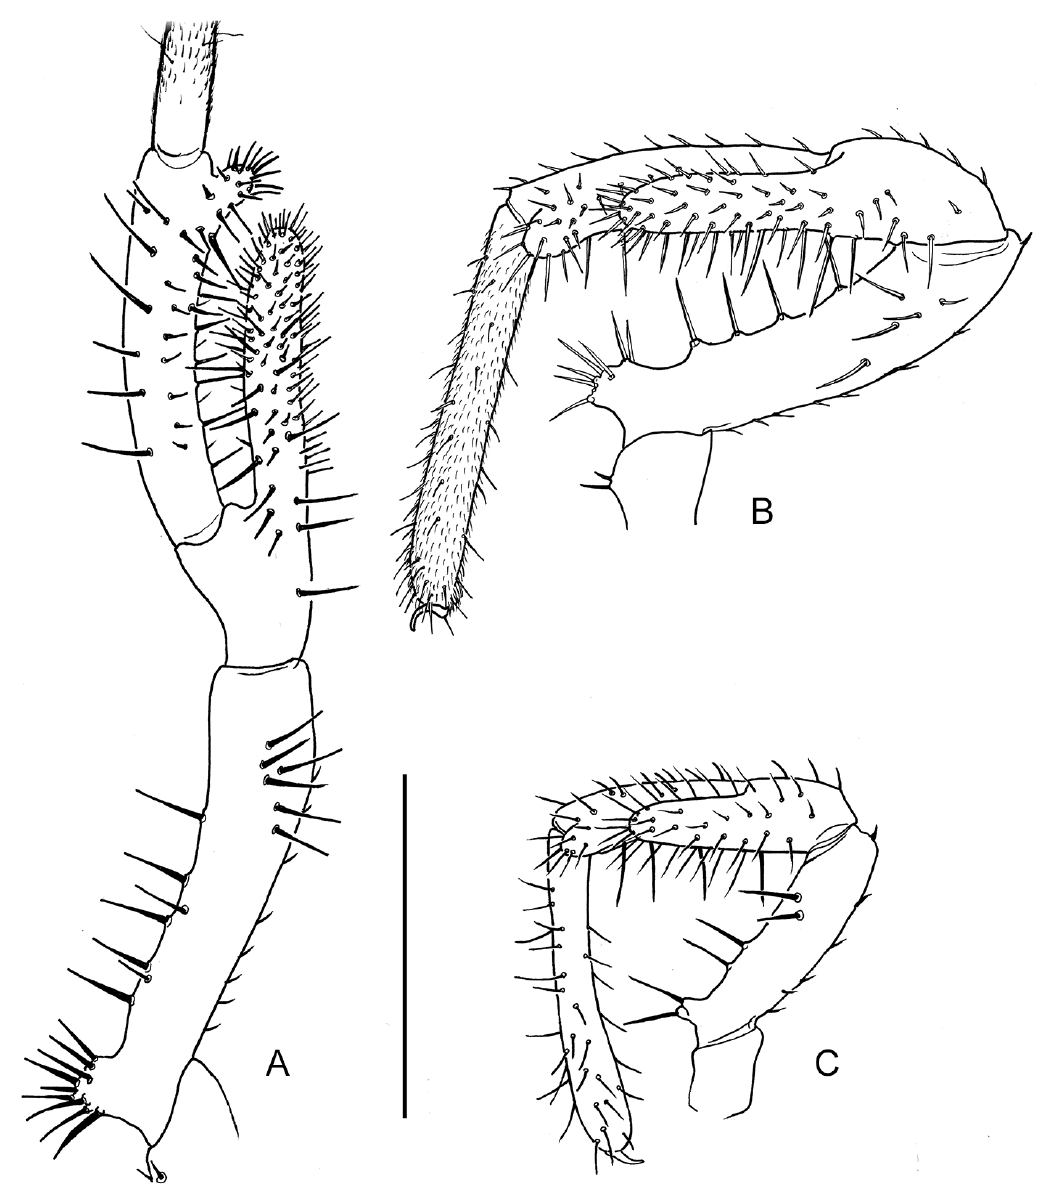
Fig. 1. Right pedipalps of juveniles of Dicranopalpus Doleschall, 1852. A . D. catariegensis sp. nov., ventral view (CHW 466). B . D. catariegensis sp. nov., median view (CJM 9005, paratype). C . D. insignipalpis (Simon, 1879), median view (CJM 7258). Scale bar =